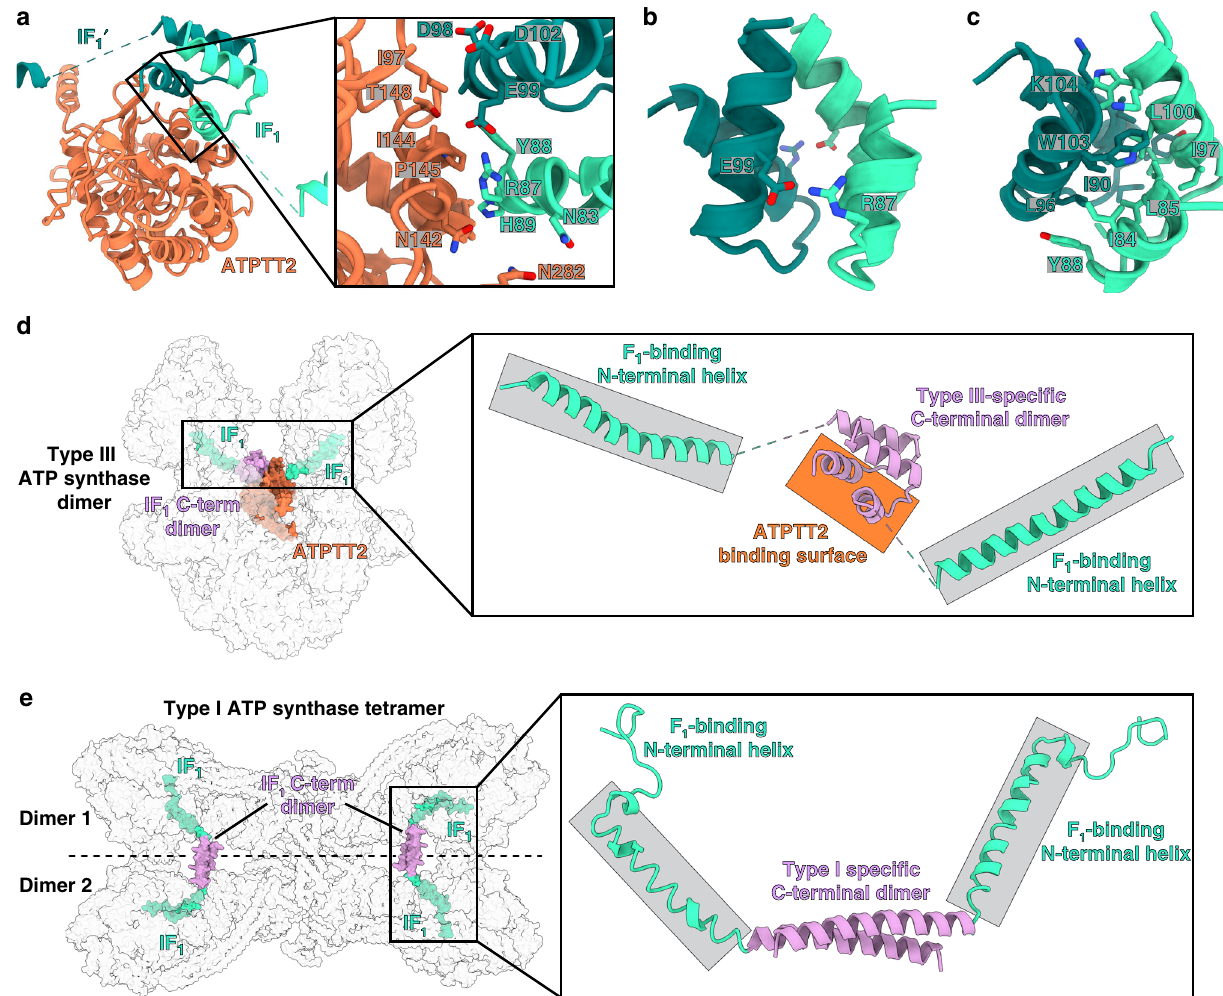
Fig. 3 ATPTT2 anchors IF 1 to the membrane. a ATPTT2 interacts with the IF 1 C-terminal domains, which dimerizes via their helical hairpins. Close-up view shows the interaction interface between ATPTT2 and IF 1 C-terminal dimer. b IF 1 C-terminal interact via electrostatic interactions on the periphery, and c form a tight hydrophobic core. d Type III ATP synthase dimer with bound intra-dimeric IF 1 . The elements forming C-terminal dimer, interact with ATPTT2 and F 1 are indicated in right panel. e porcine type I ATP synthase tetramer (PDB 6J5K) [https://www.rcsb.org/structure/6J5K] with bound inter-dimeric IF 1